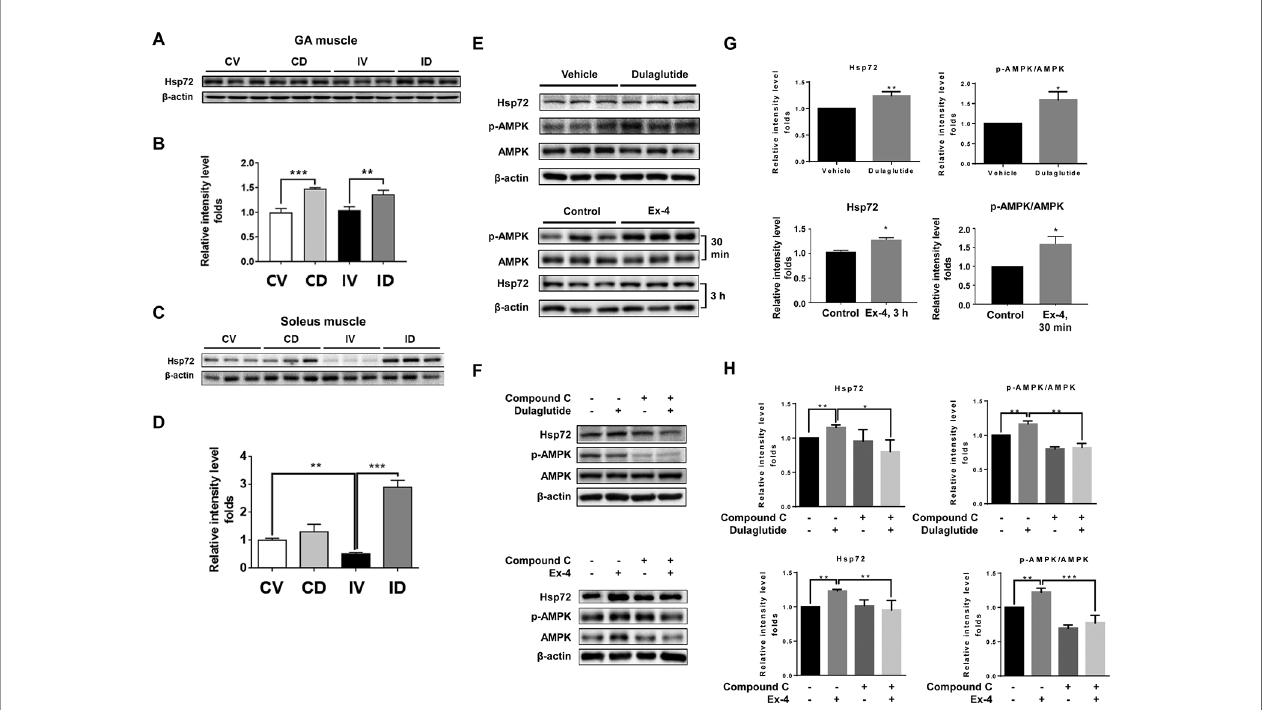
FIGURE 6 | GLP-1 receptor agonist treatment increased Hsp72 protein expression through the regulation of AMPK signaling. (A) Immunoblotting and (B) quanti fi cation analyses of Hsp72 protein expression in GA muscle. (C) Immunoblotting and (D) quanti fi cation analyses of Hsp72 protein expression in soleus muscle. Beta-actin was used as a loading control. Data are shown as mean ± S.E.M, n = 5; *p < 0.05, **p < 0.01, ***p < 0.001. CV, control + vehicle; CD, control + dulaglutide; IV, immobilization + vehicle; ID, immobilization + dulaglutide. (E) Immunoblotting and (G) quanti fi cation analyses of Hsp72 and p-AMPK proteins in C2C12 myotubes treated with dulaglutide (1.5 µg/ml, 12 h) or Ex-4 (20 nM, 30 min or 3 h). (F) Immunoblotting and (H) quanti fi cation analysis of Hsp72 and p-AMPK proteins in C2C12 myotubes pre-treated with compound C at 20 µM for 1 h and then exposed to dulaglutide (1.5 µg/ml, 3 h) or Ex-4 (20 nM, 3 h). Beta-actin was used as the loading control. Data are shown as mean ± S.E.M, n = 3; *p < 0.05, **p <